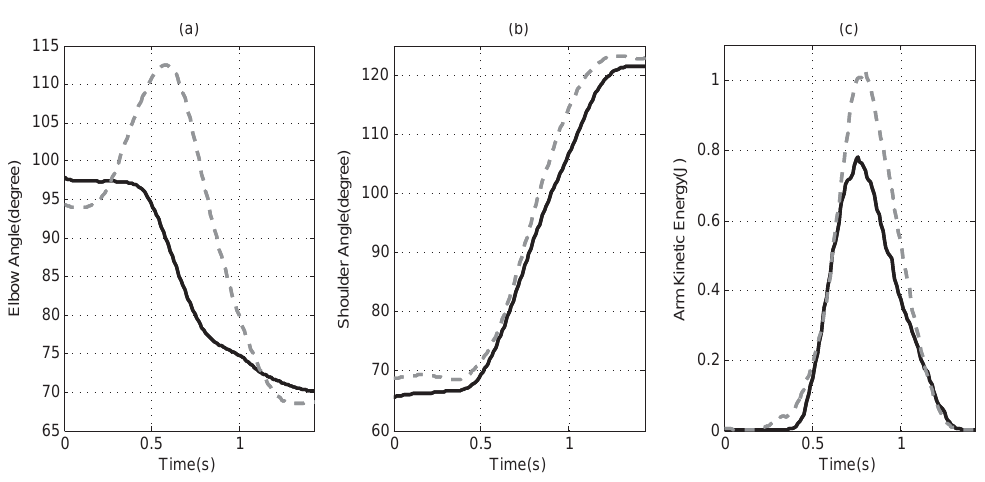
Figure 10: Measured elbow, shoulder joint angles and energy property profiles of two trajectories in Case E :